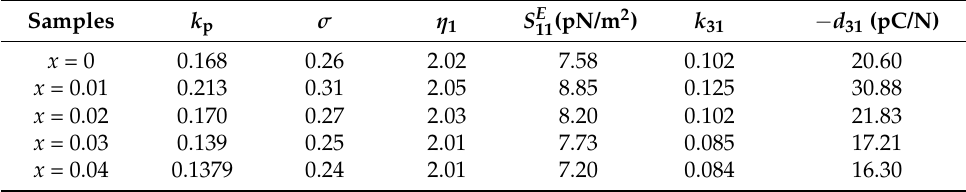
Table 1. Electromechanical coupling parameters of porous BNBT6- x Sm